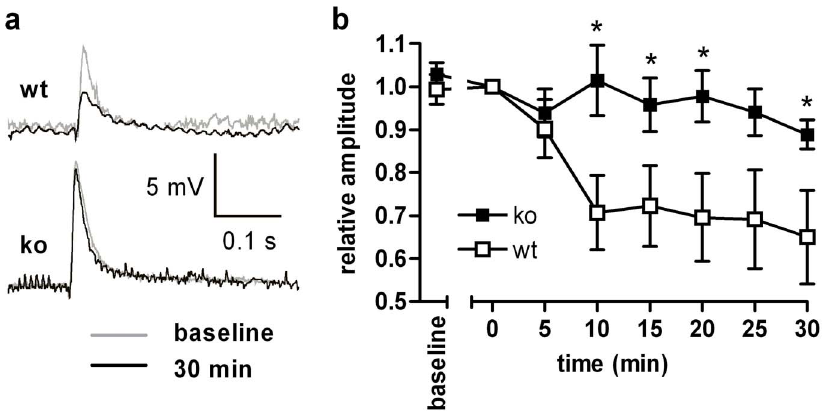
Figure 7. Reduced synaptic plasticity in RGS9-deficient mice. ( a ) EPSPs in sMSN before and 30 min after tetanic stimulation of glutamatergic afferents. ( b ) Normalized amplitudes of evoked EPSPs during the last 5 minutes of baseline stimulation and during the first 30 minutes following tetanic stimulation. Note the expected reduction of amplitudes in wt animals which was not seen in RGS9-deficient animals (*P # 0.05, n=10 (ko) and 9 (wt),